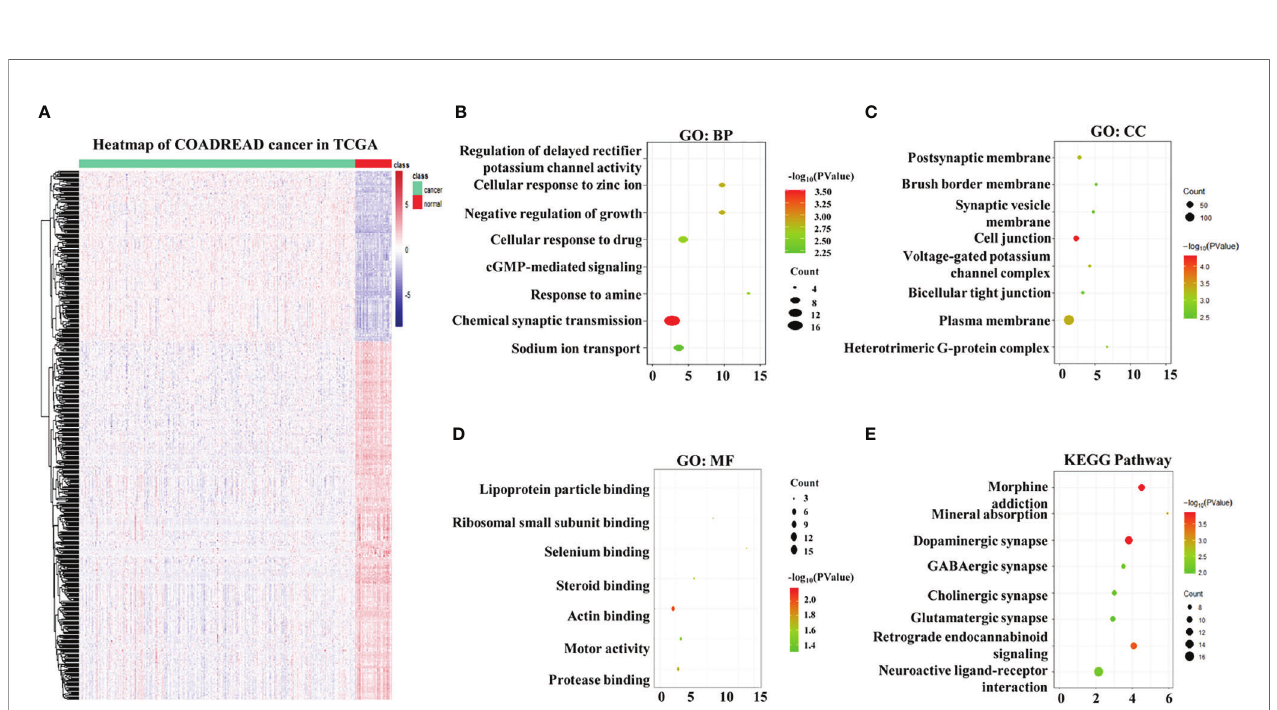
FIGURE 2 | Overlapping immune-related genes (IRGs) and functional enrichment analysis. (A) Heatmap of IRGs in The Cancer Genome Atlas. (B) Biological process analysis of IRGs. (C) Cellular component analysis of IRGs. (D) Molecular function analysis of IRGs. (E) Kyoto Encyclopedia of Genes and Genomes analysis of